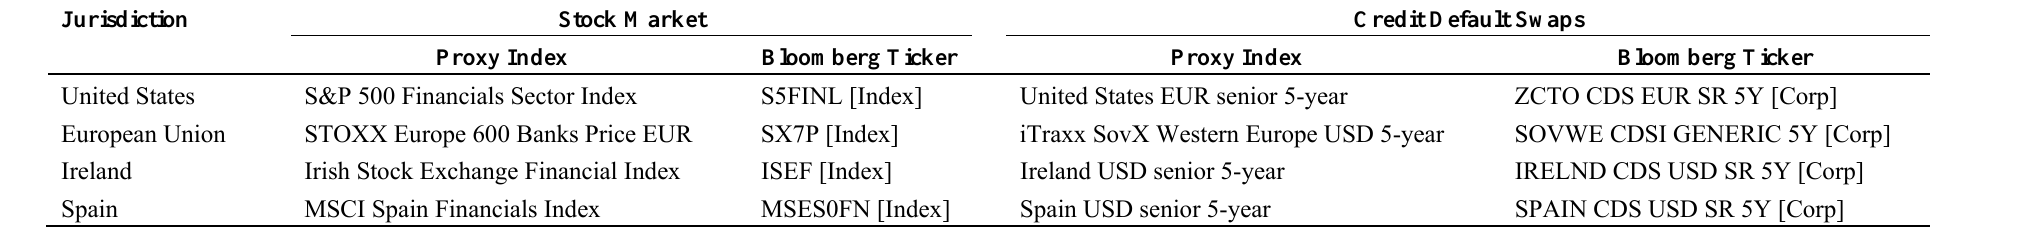
Table 2. Market Data: Financials Stock Price Index and CDS Spreads.